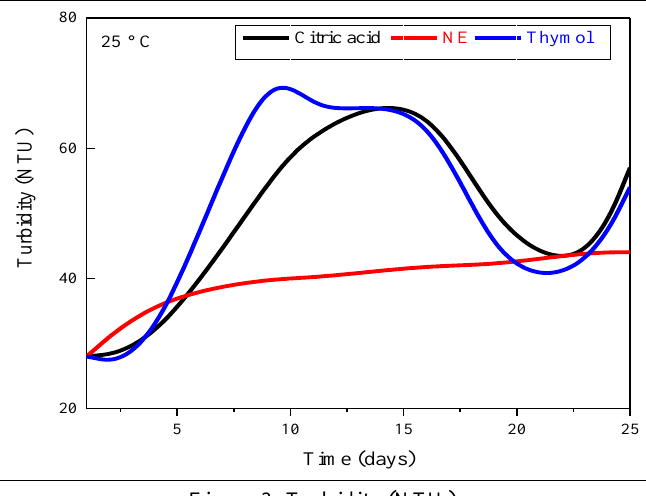
Figure 3: Turbidity (NTU).